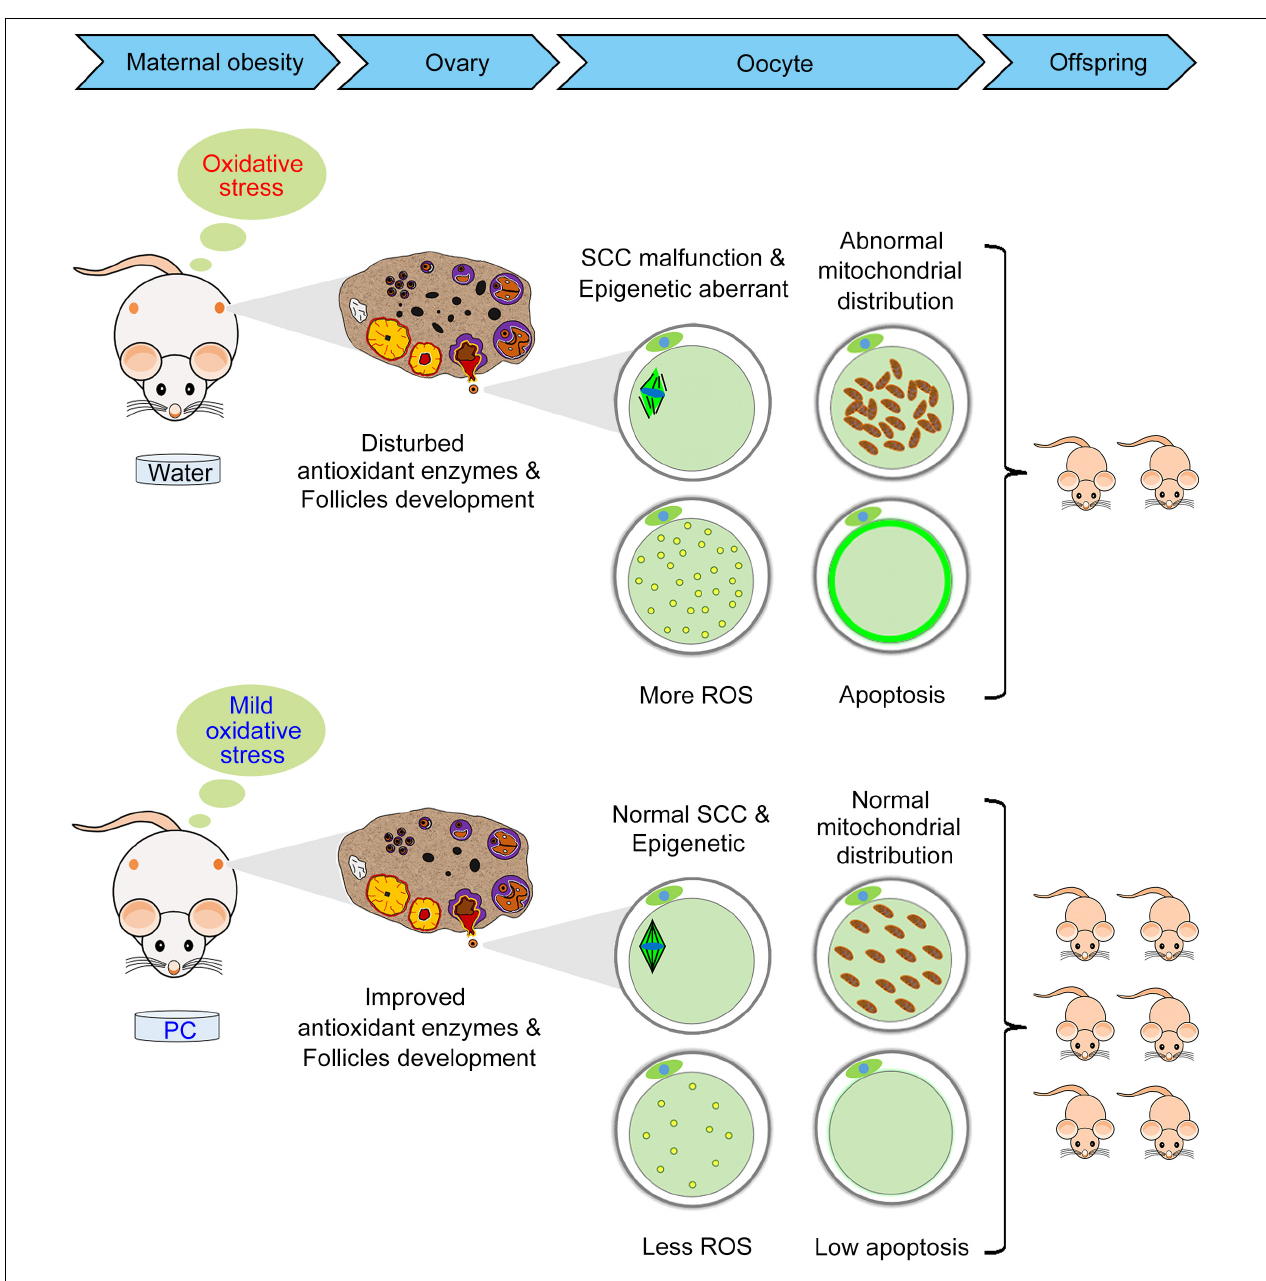
FIGURE 8 | Diagram illustrating the beneficial effects of PC that improved reproductive ability in obese female mice by alleviating oxidative stress-induced ovarian and oocyte damage. The intragastric administration of PC reduced the number of atretic follicles and improved antioxidant enzymes in obese female mice ovaries. The administration of PC also rescued oocyte meiosis defects, including aberrant epigenetic effects, abnormal mitochondrial distribution, ROS accumulation, and early apoptosis. Therefore, ovary/oocyte quality, and the fertility of obese female mice was improved after PC